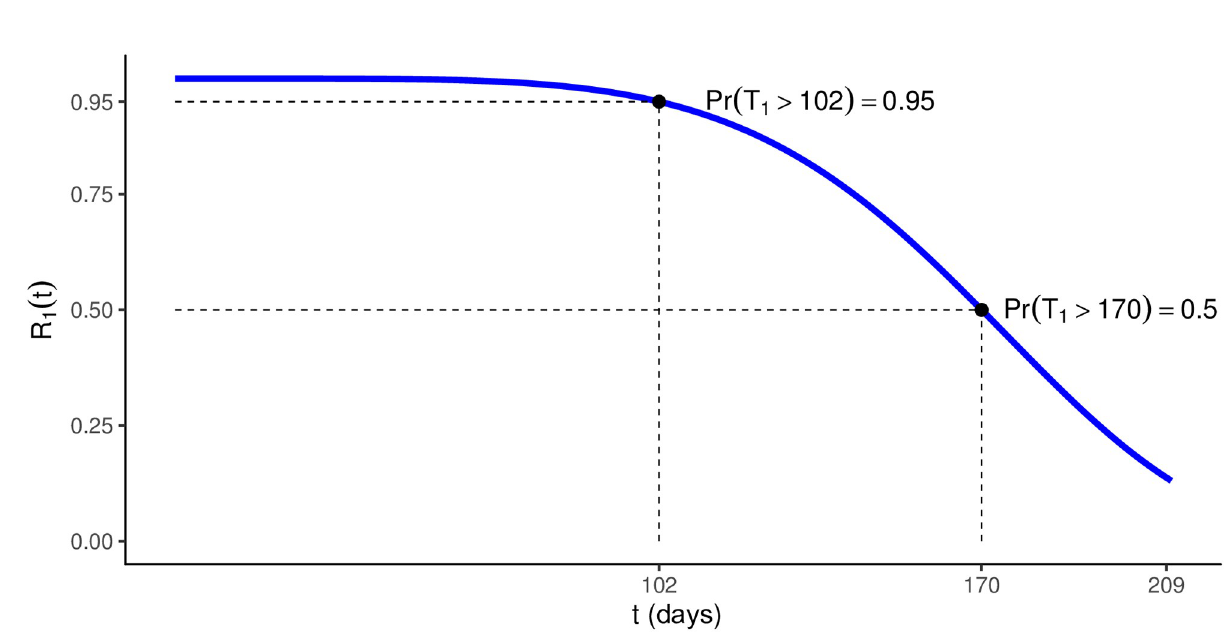
Fig 9. Reliability requirements. Traction